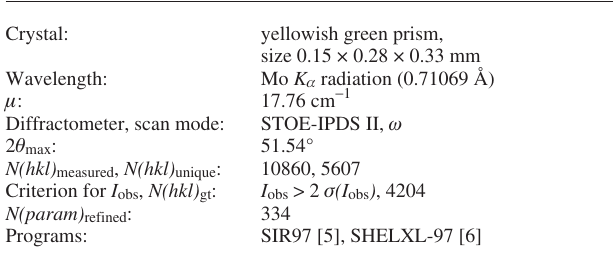
Table 1. Data collection and handling.